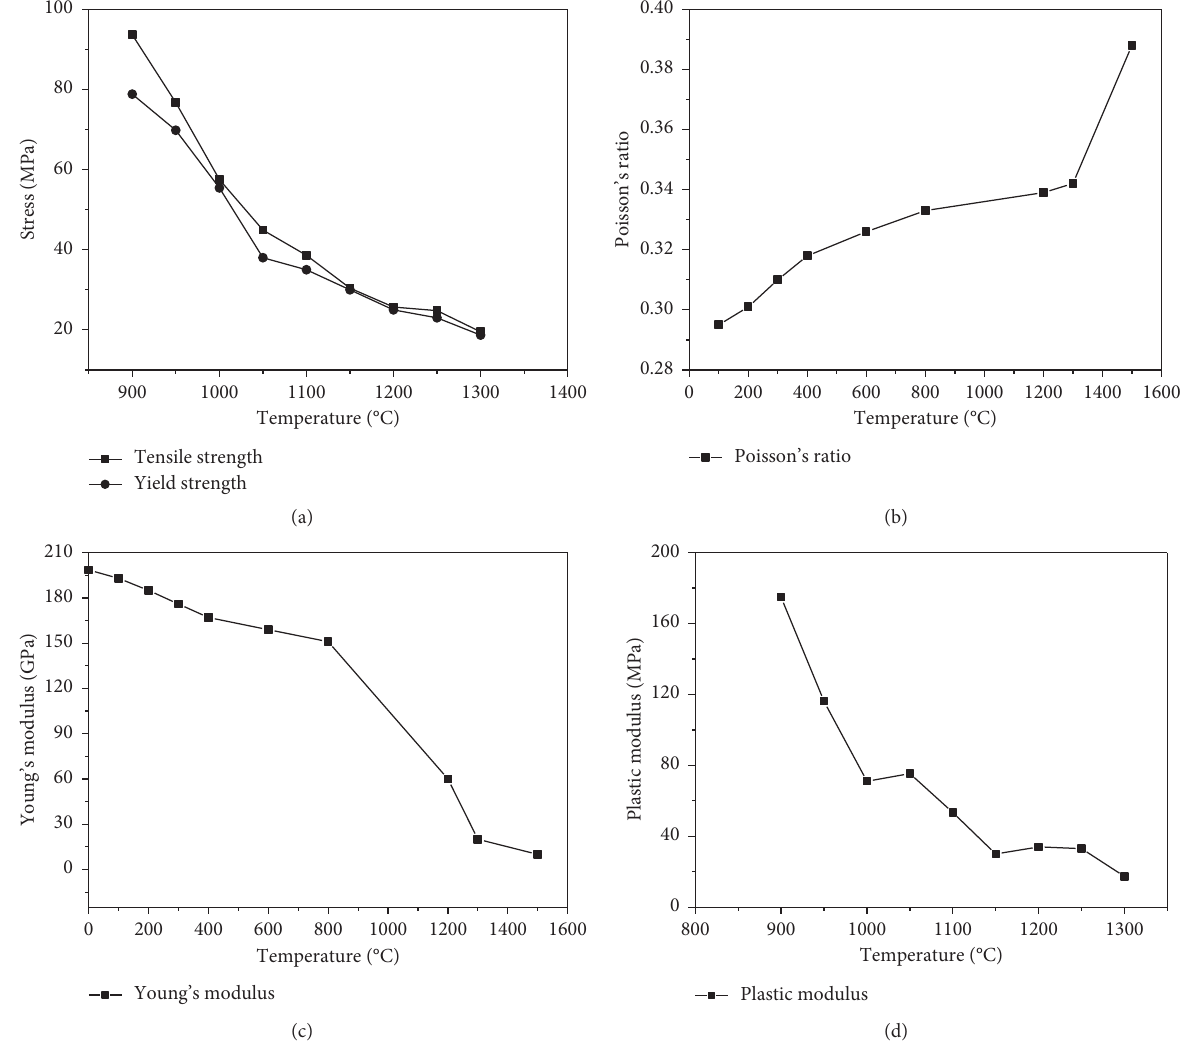
Figure 2: High-temperature mechanical properties of nuclear power stainless steel. (a) Yield strength and tensile strength. (b) Poisson’s ratio. (c) Young’s modulus. (d) Plastic modulus.